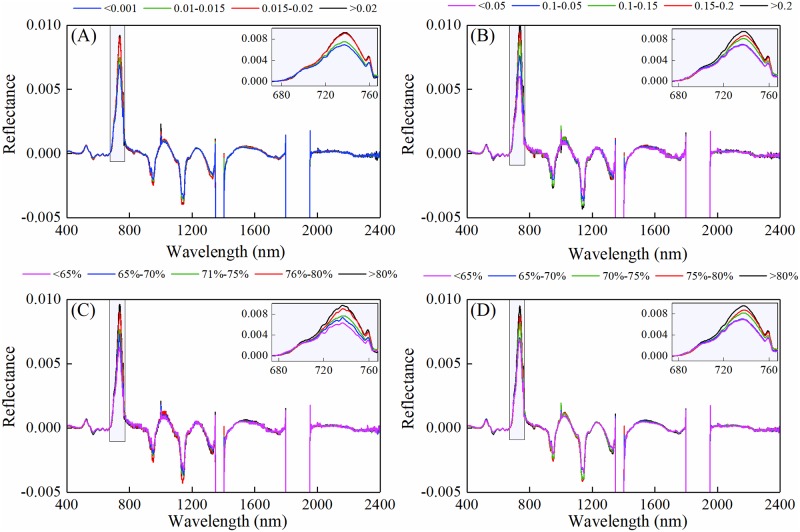
First derivative reflectance at various plant water status in winter wheat.Different color represents gradients of water metrics. (A) equivalent water thickness (EWT), (B) canopy water content (CWC), (C)leaf water content (LWC) and (D) plant water content (PWC).